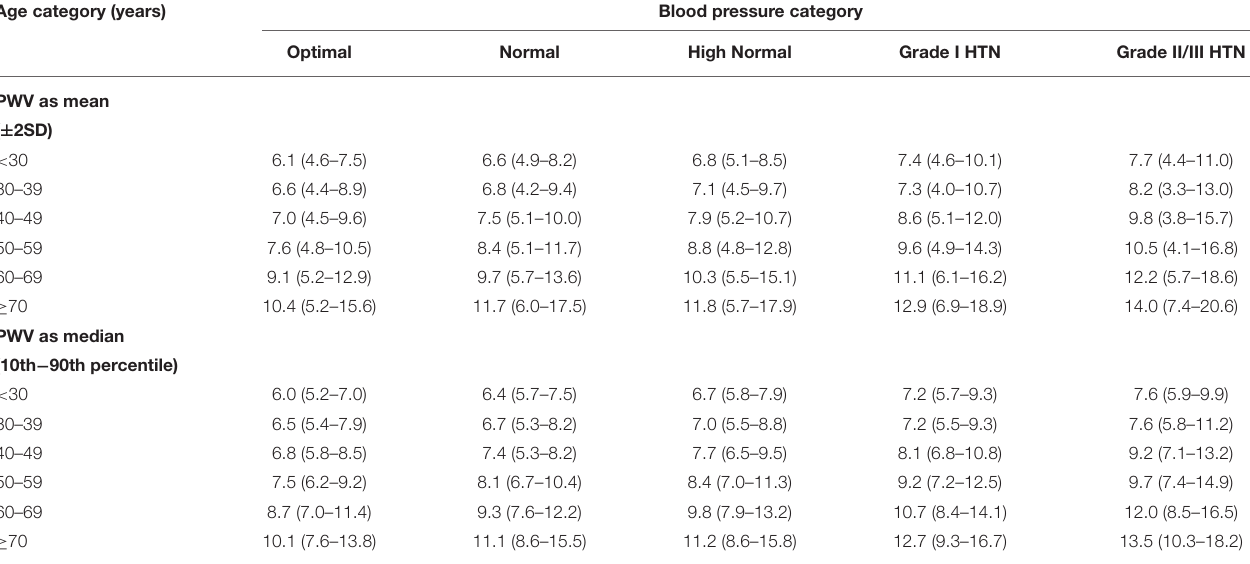
TABLE 1 | Distribution of pulse wave velocity (PWV) values (m/s) in the reference value population (11,092 subject) according to age and blood pressure category. Age category (years) Blood pressure category Optimal